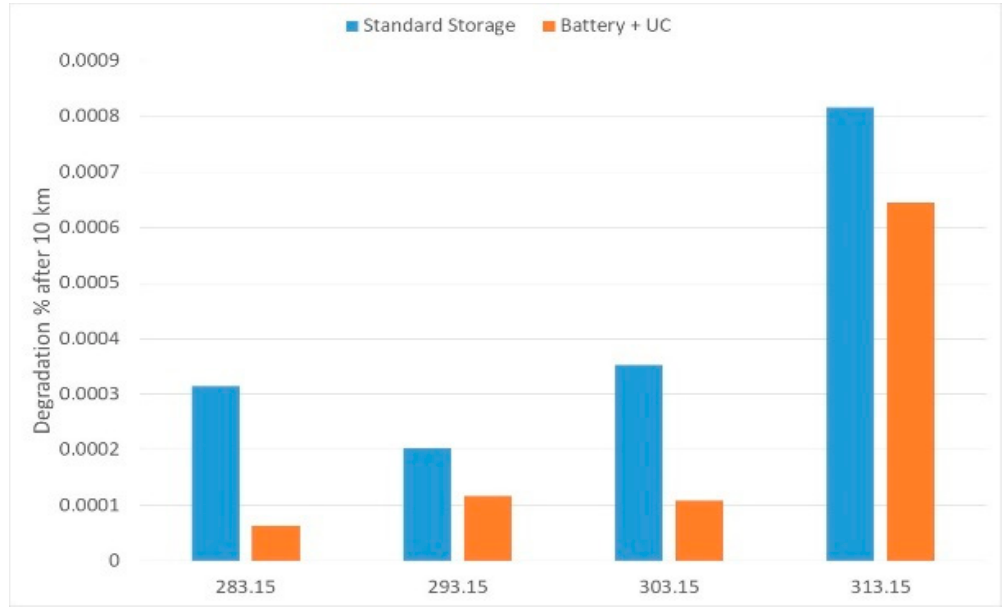
Figure 20. Between the standard storage and Battery +UCs during the WLTC Class1 for different ambient temperature.